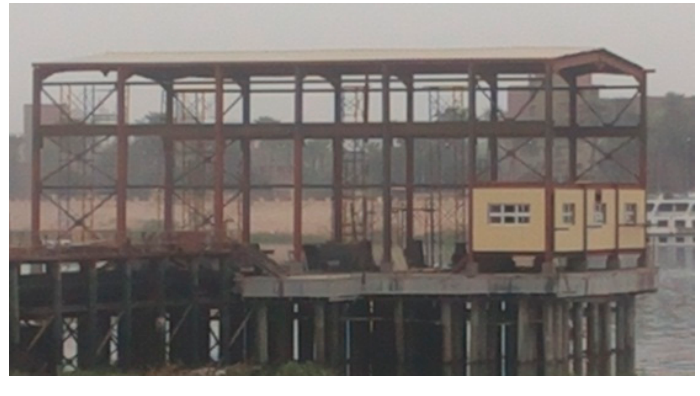
Figure 1. Platform view. Table 1. Geometrical and material properties for the elements of the platform and piles.